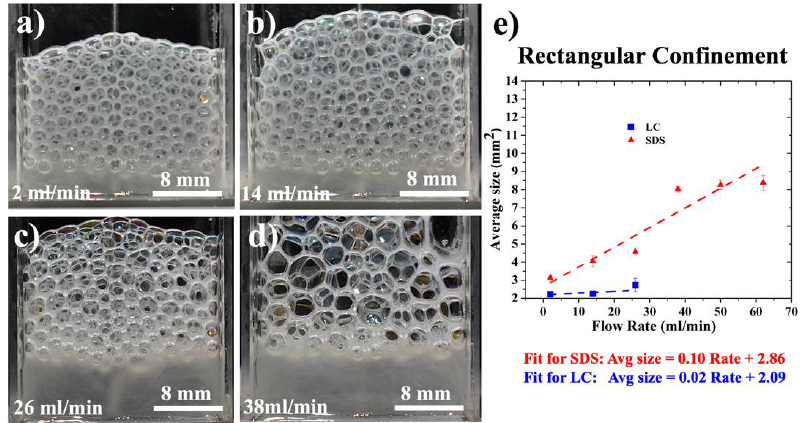
Figure 2. Fabrication of smectic foam under rectangular confinement. The rectangular containers were constructed from glass slides with a length of 25 mm and a width of 6 mm. Images of LC foams created at an airflow rate of ( a ) 2 mL/min, ( b ) 14 mL/min, ( c ) 26 mL/min, and ( d ) 38 mL/min. ( e ) Average areas of the foam cells near the container’s wall for LC (squares) and SDS (triangles) as a function of the airflow rate. Here, we assume that the volume of the 3D cells is proportional to their areas near the glass wall.